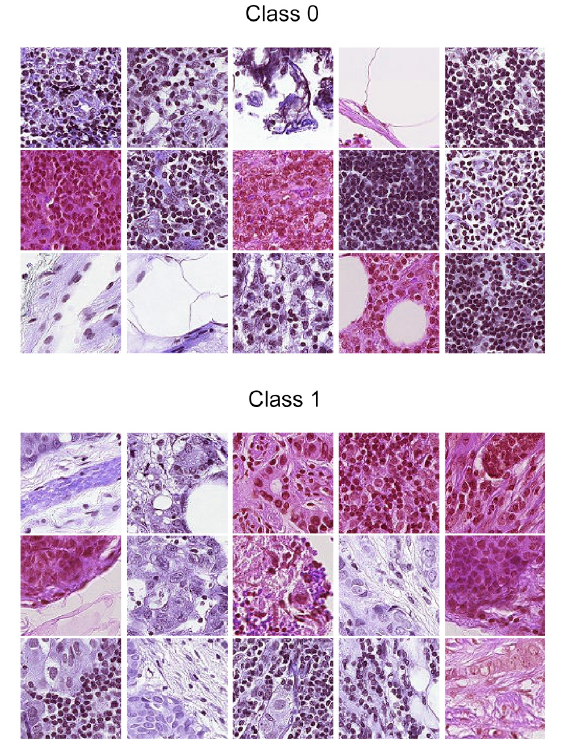
Figure 1. Samples from the Patch Camelyon (P-CAM) dataset by Veeling et al. [4]. Class 1 indicates that there is at least one pixel of tumor tissue in the center of the image (the center is a 32 by 32 pixel square in the middle of the patch), while Class 0 indicates the